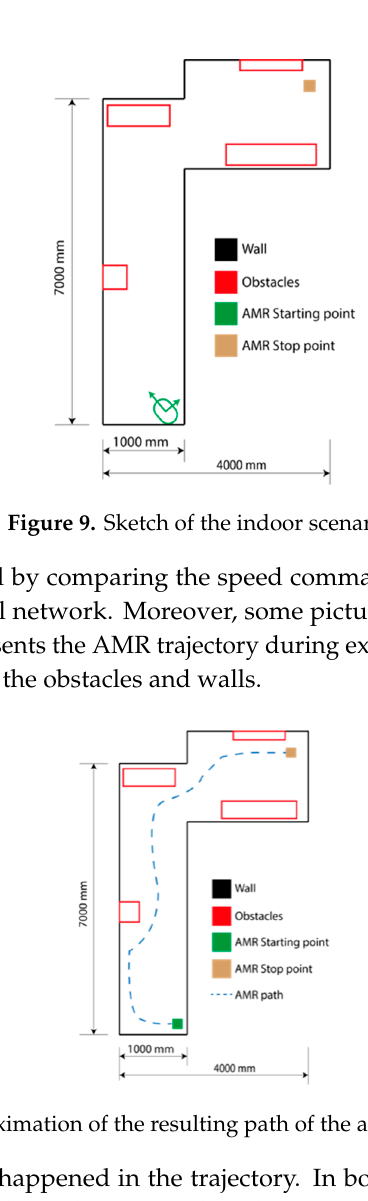
( b ) Figure 12. The first obstacle in the trajectory: ( a ) Illustration; ( b ) the real object in the scenario.